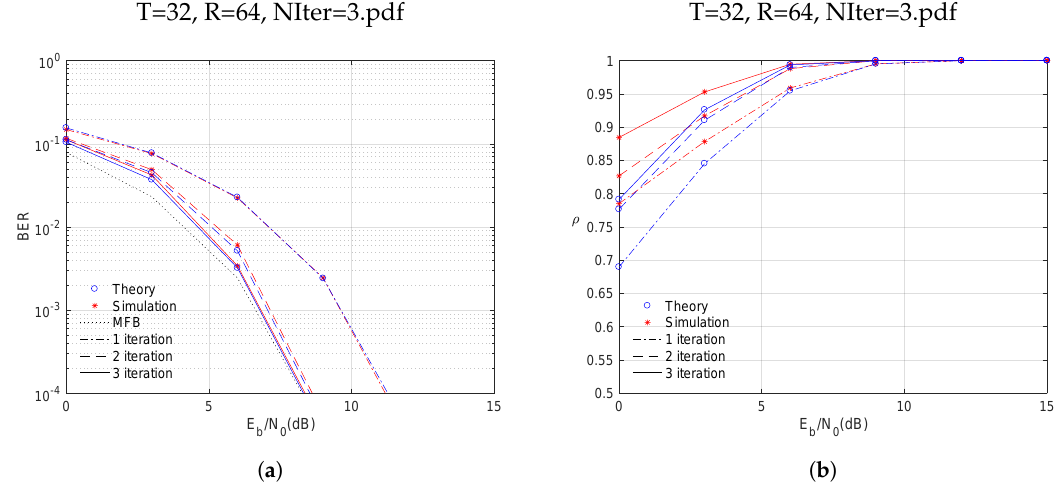
Figure 6. Theoretical/simulated BER performance and correlation factor for a receiver that combines IB-DFE and MRC in an mMIMO system with 3 iterations. ( a ) BER performance. ( b ) Correlation factor ( ρ